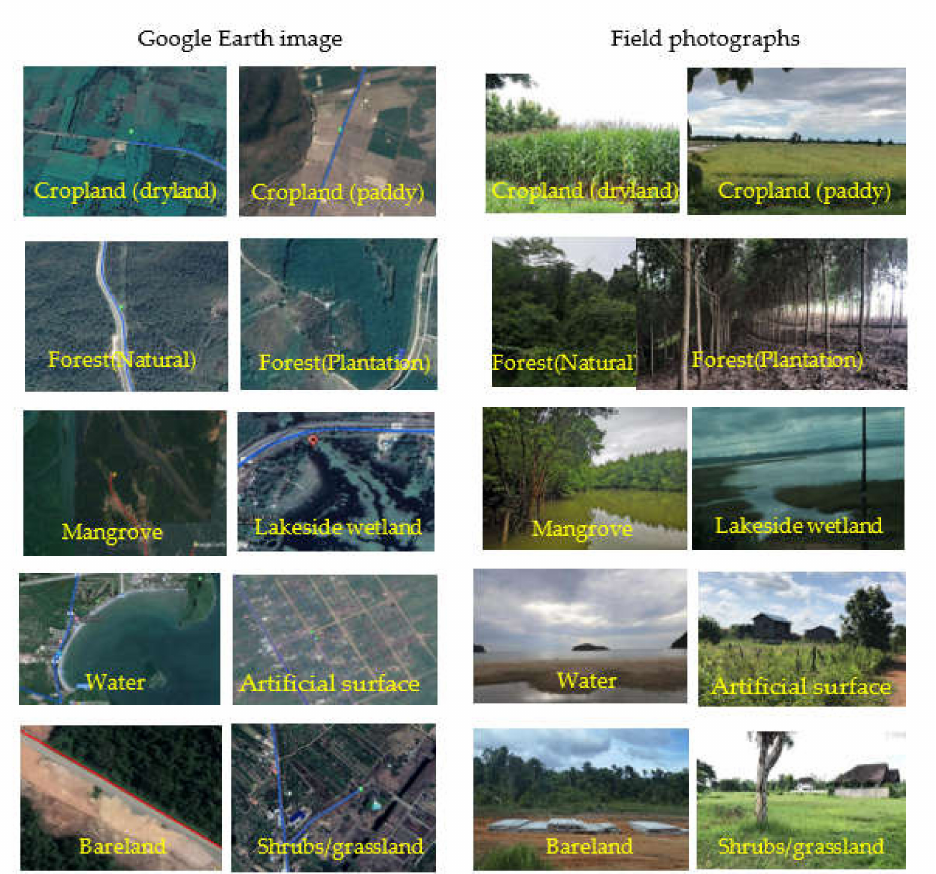
Figure 10. Field photographs of typical samples in the study area.